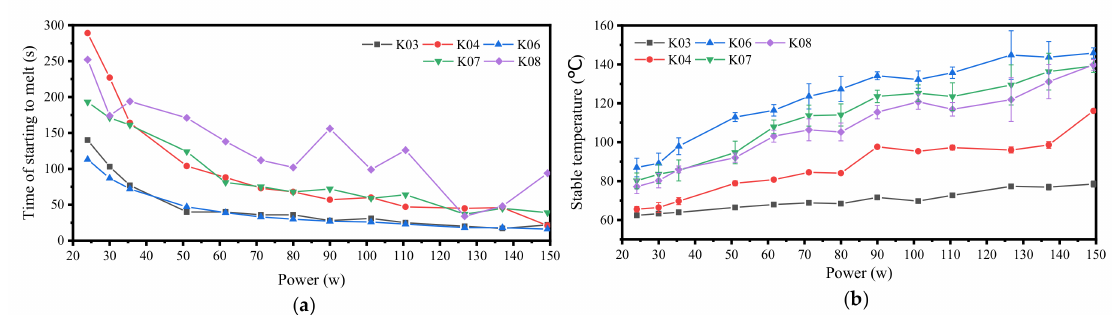
Figure 11. Summary of phenomena in the melting process of para ffi n: ( a ) at di ff erent power, the heating time of each position starting to melt; ( b ) the stable temperature of each